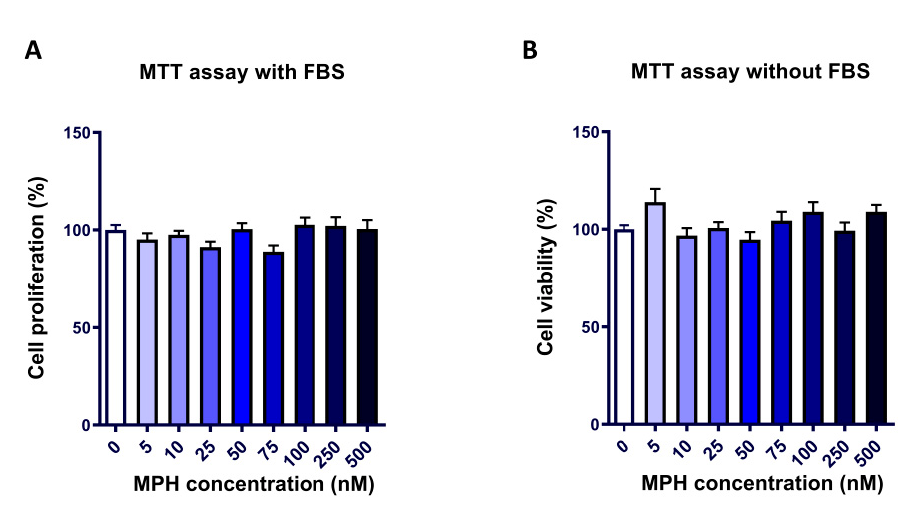
Figure 1. MTT assay to test the effects of 48-h treatment with MPH in ATDC5 cells on proliferation (with FBS) ( A ) and viability (without FBS) ( B ) in the culture medium (n = 3). None of the doses tested caused a significant change in the viability or proliferation of the cells. MTT: (3-(4,5-Dimethyl-2-thiazolyl)-2,5-diphenyl-2H-tetrazolium bromide); MPH: methylphenidate hydrochloride.